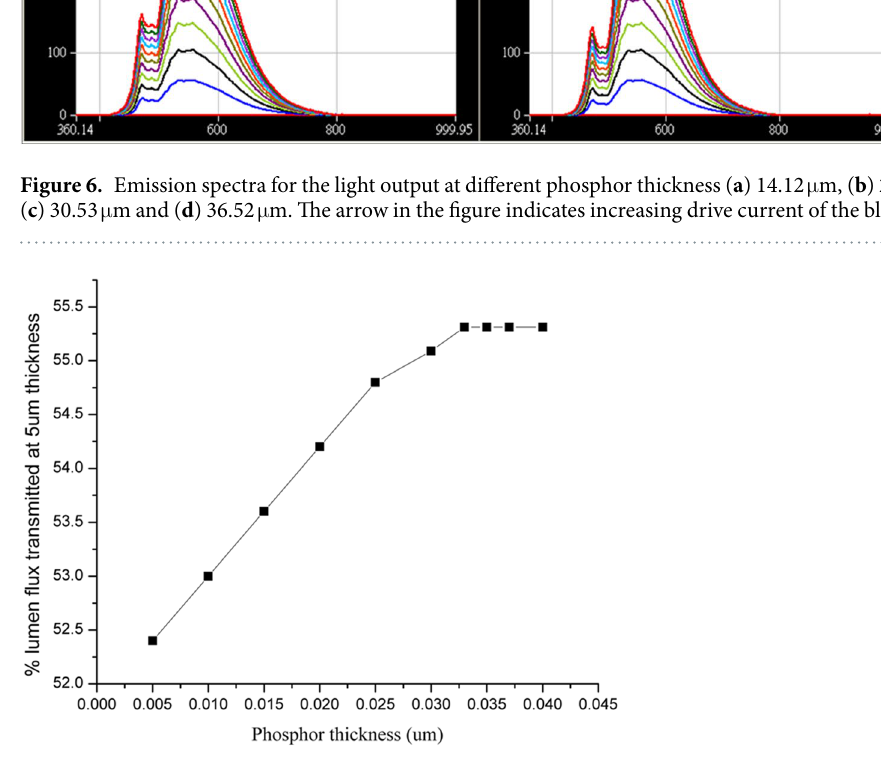
The change of refractive indexes with temperature is not considered as well, even though the temperature of the phosphor layer is increasing with the thickness of the phosphor layer as will be shown later in this work. Figure 7 shows the % of lumen flux transmitted out of the phosphor layer vs the phosphor thickness with our simple model. We can indeed see the decreasing rate of the light output intensity with the phosphor layer thick- ness and a plateau is observed beyond 30 μ m of phosphor layer as very few phosphor particles reside and it leaves mainly silicone at the top segment. This sedimentation seem to explain the surface roughness profile shown in Fig. 5(b). The drop in the rough- ness after 30 μ m of phosphor could be expected with the phosphor sedimentation phenomena. If most of the phosphor particles are sediment up to the thickness of 30 μ m, then the region above 30 μ m will mostly be the sil- icone medium, and it will be smoother as very few phosphor particles are on the surface of the interface between the silicone and the air, in analogy to the sedimentation of sandy water. As smooth surface tends to reflect more light back to the phosphor as seen earlier in Fig. 7, the drop in the lumen light output could be due to the surface reflection as phosphor sedimentation could not explain the plateau of the light reflection after 30 μ m. This seems to be consistent with Fig. 4 where the blue light output decreases